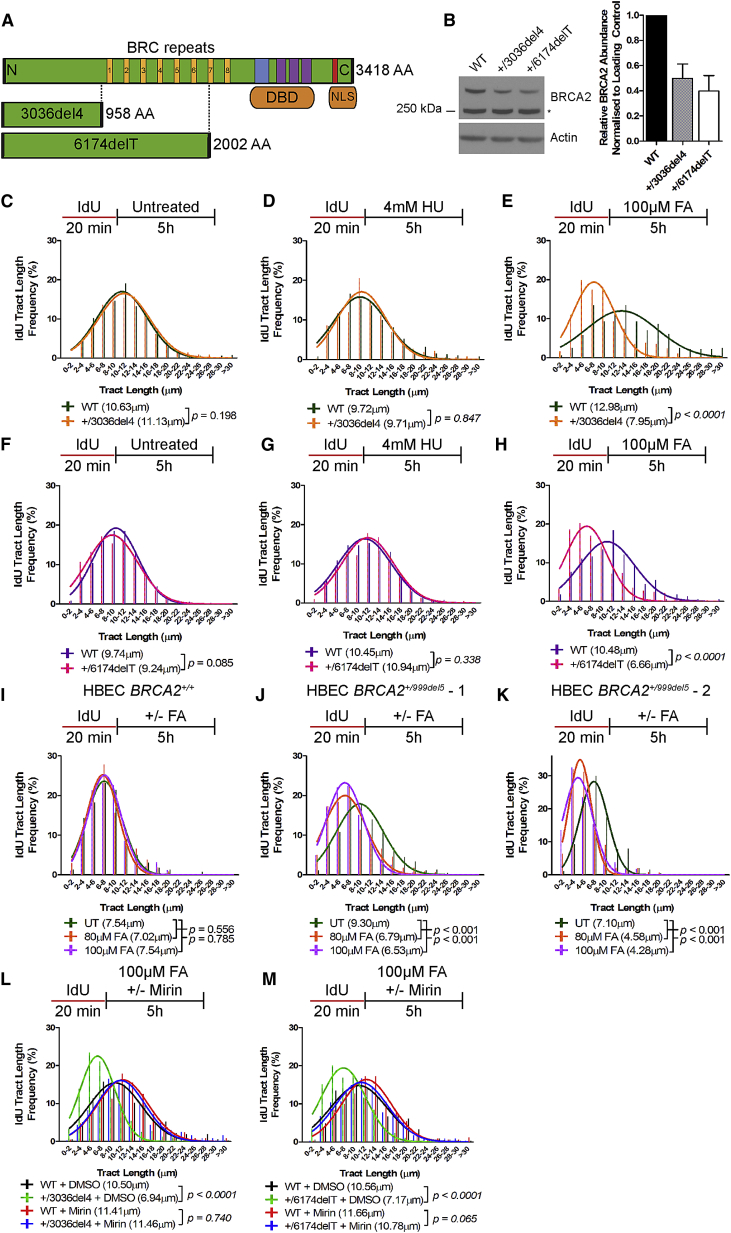
Heterozygosity for BRCA2 Truncating Mutations Selectively Sensitizes Cells to Formaldehyde-Induced Replication Stress(A) The pathogenic BRCA2 truncating mutants used in this work. DBD, DNA binding domain; NLS, nuclear localization signal.(B) BRCA2 protein levels in HeLa Kyoto cells. ∗Denotes non-specific bands. The histogram plots normalized BRCA2 band intensities (mean ± SEM, n = 3).(C–E) IdU tract length frequency distributions of wild-type HeLa Kyoto versus BRCA2+/3036del4 heterozygous cells (C) without treatment, (D) with 4 mM HU, and (E) with 100 μM FA.(F–H) IdU tract length frequency distributions of wild-type HeLa Kyoto versus BRCA2+/6174delT heterozygous cells (F) without treatment, (G) with 4 mM HU, and (H) with 100 μM FA.(I) IdU tract length frequency distributions of BRCA2+/+ HBECs treated with or without FA for 5 hr.(J) IdU tract length frequency distributions of BRCA2+/999del5 - 1 HBECs treated with or without FA for 5 hr.(K) IdU tract length frequency distributions of BRCA2+/999del5 - 2 HBECs treated with or without FA for 5 hr.(L and M) IdU tract length frequency distributions of HeLa Kyoto cells after treatment with FA in the presence (100 μM) or absence (DMSO) of Mirin. Results in (C)–(M) represent at least two independent experiments.See also Figures S1 and S2.